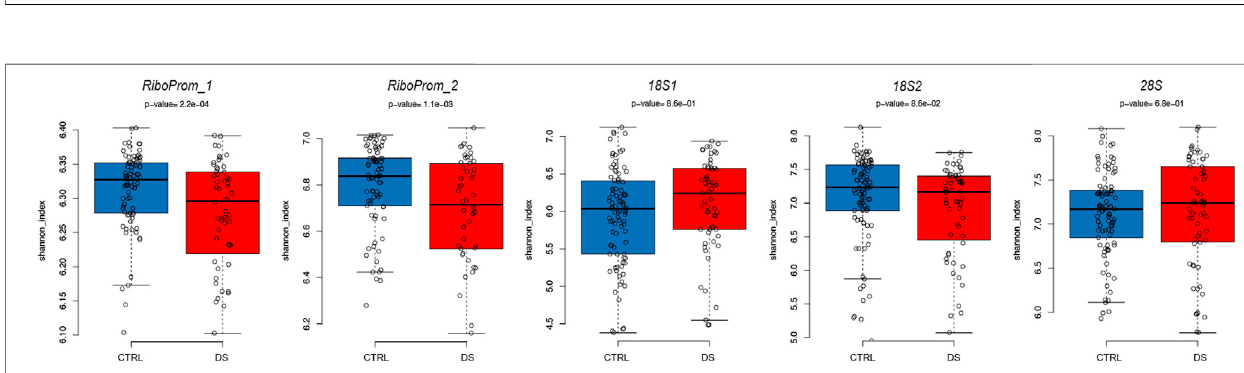
S4 ; Supplementary S5 , respectively). We did not observe any signi fi cant result except for CpG10 within RiboProm_2 , for which RNA45S expression and DNAm were negatively correlated in controls. RNA45S expression did not show signi fi cant association with age neither in persons with DS (estimate = -0.0026, p -value =